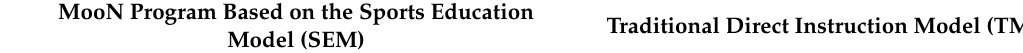
Table 1. Characteristics of educational interventions in experimental and control